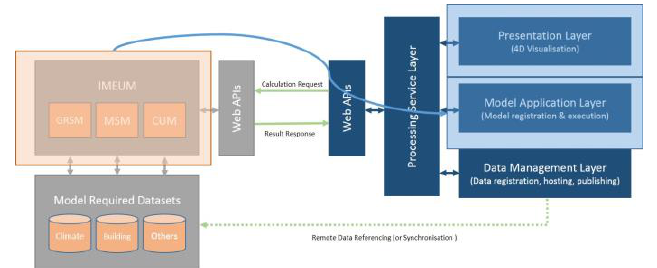
Figure 1: Conceptual design and interrelations of the project